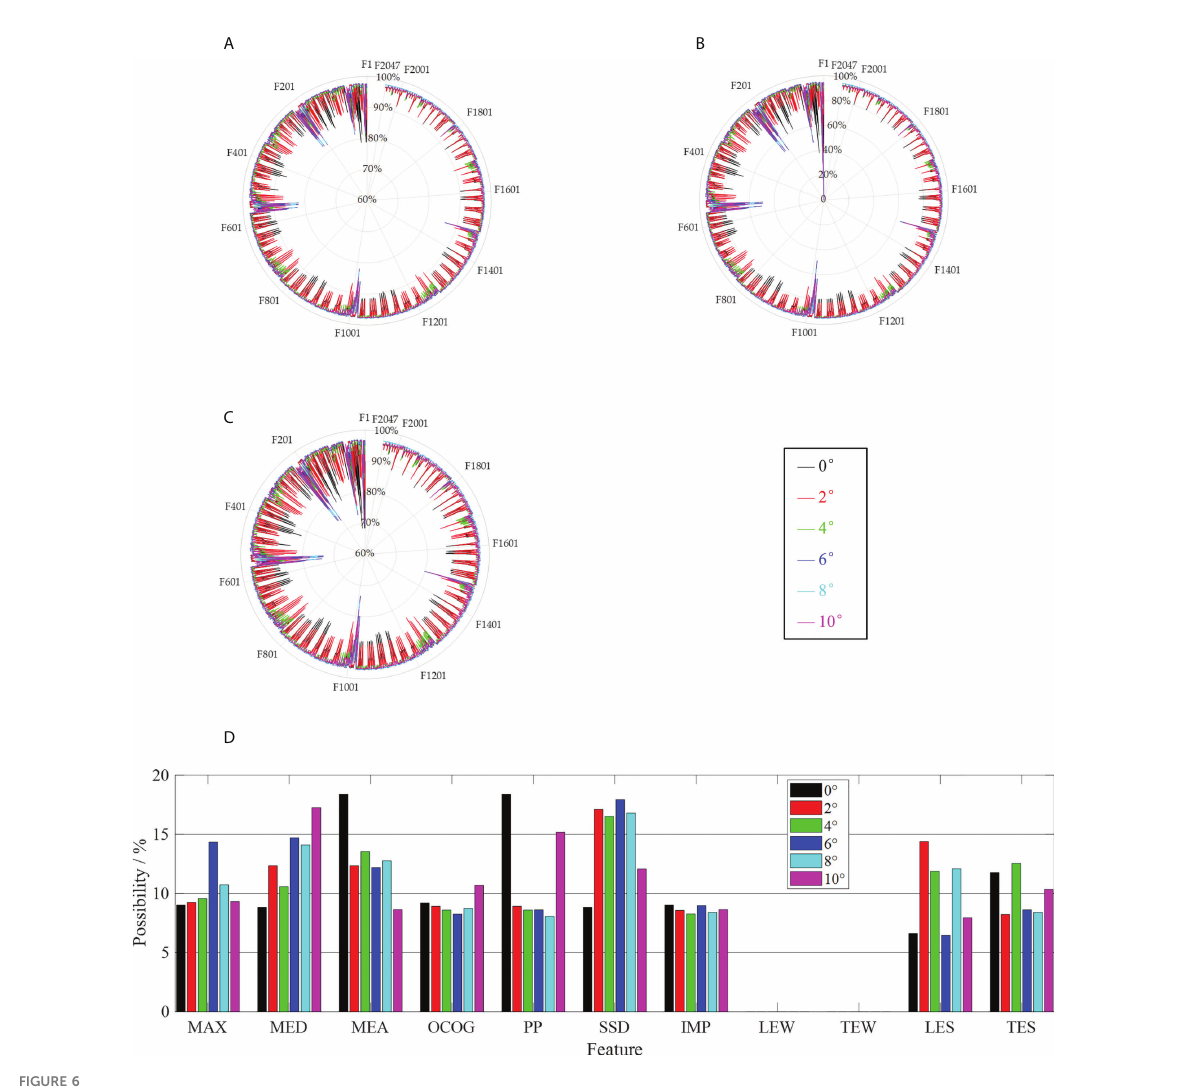
FIGURE 6 F1 scores and overall accuracies of 2047 feature combinations for sea ice and sea water discrimination at six small incidence angles. (A) F1 scores of sea ice; (B) F1 scores of sea water; (C) Overall accuracies; (D) Occurrence possibilities of single features in the top 5% feature combinations. The numbers in (A) – (C) represent the ID Numbers of the feature combinations, seen in the ‘ Supplementary Material ’ fi le.